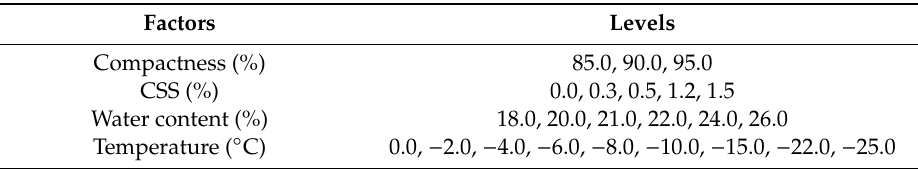
Table 4. Influence levels of four factors in frost heave experiments